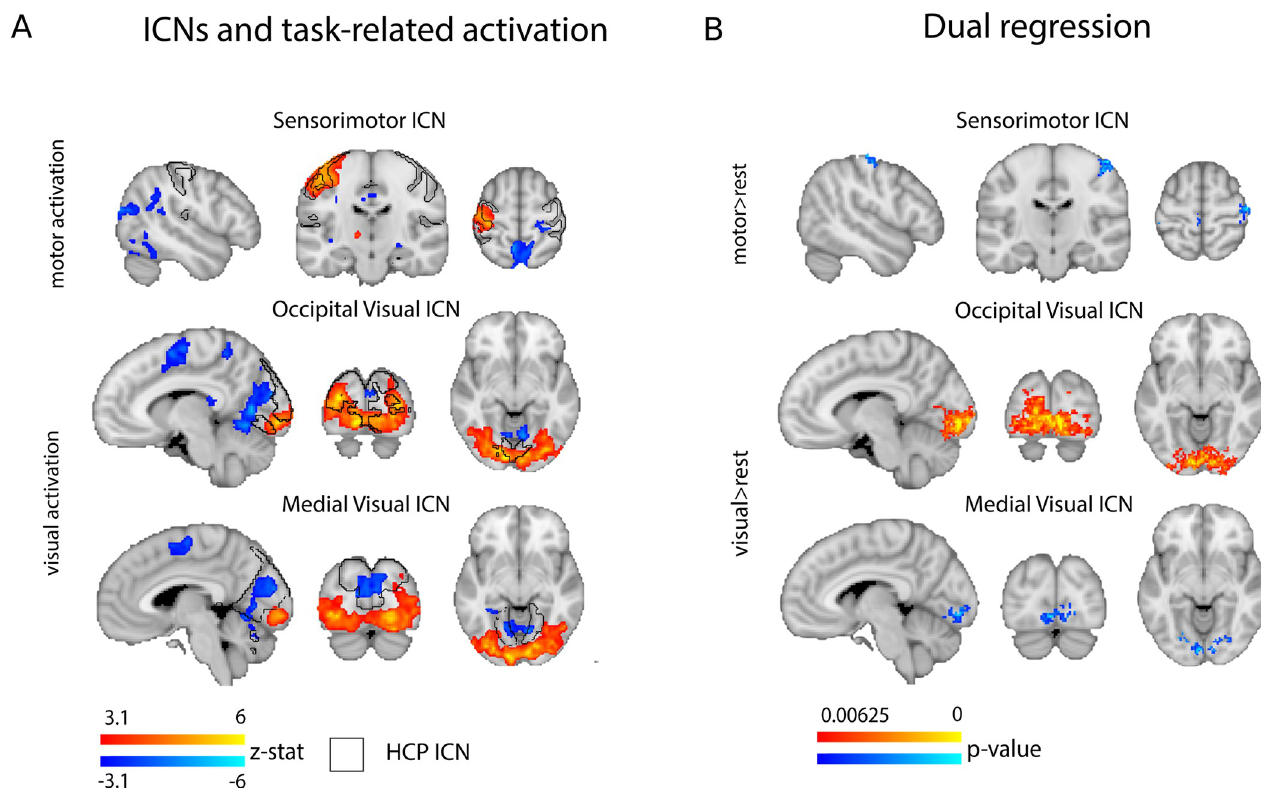
Fig 5. Intra-network FC differences between task and rest. (A) Brain regions activated by the motor condition overlap with the Sensorimotor ICN; brain regions activated during the visual condition overlap with the Occipital Visual ICN; and, brain regions deactivated during the visual condition overlap with the Medial Visual ICN. Brain (de)activation is shown in blue and red, the boundaries of the ICNs is illustrated by the black contour line. (B) Results of the dual regression analysis reveal: lower FC to the ipsilateral part of the Sensorimotor ICN during motor task; increased FC within the Occipital Visual ICN during visual task; and decreased connectivity between Medial Visual ICN and Occipital Visual ICN during the visual task.